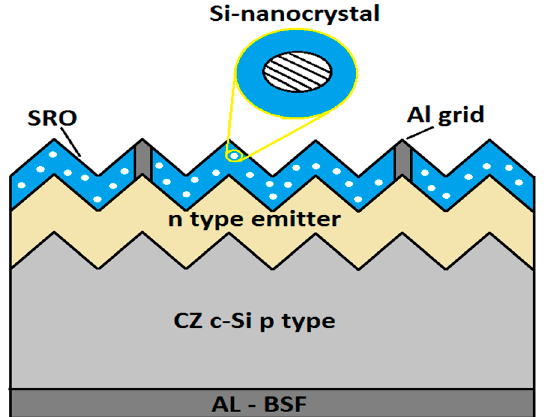
Figure 1. Structure of the UV silicon photodetector using an off-stoichiometric silicon oxide layer with silicon nanocrystals embedded in a silicon dioxide